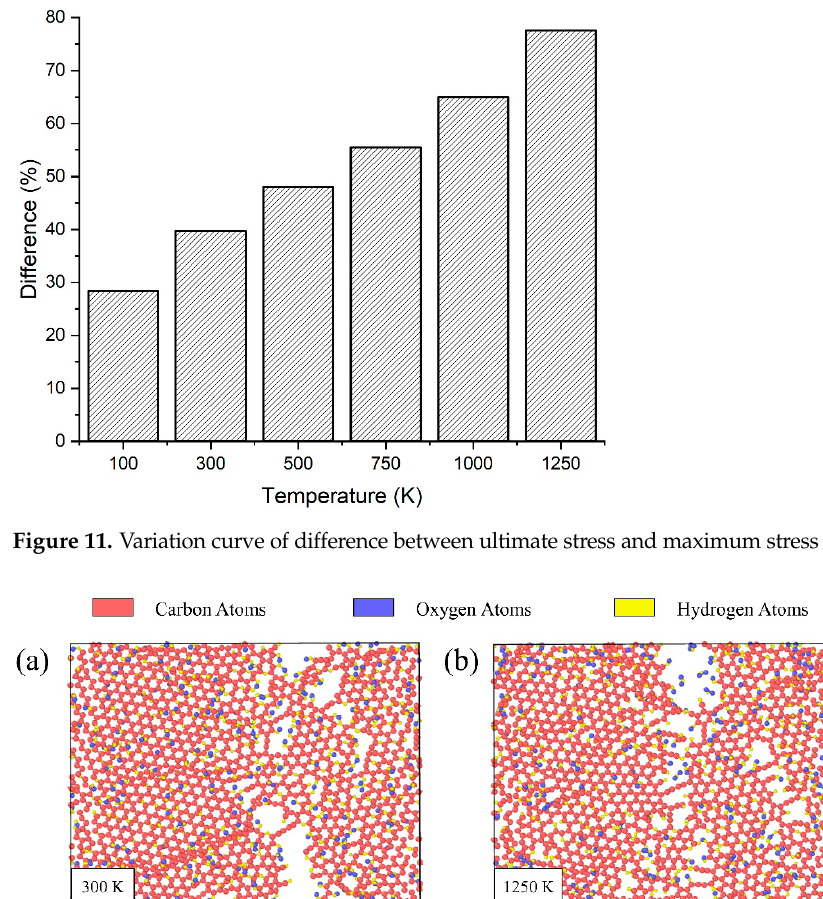
Figure 10. Ultimate stress and maximum stress of PGO at different temperatures.